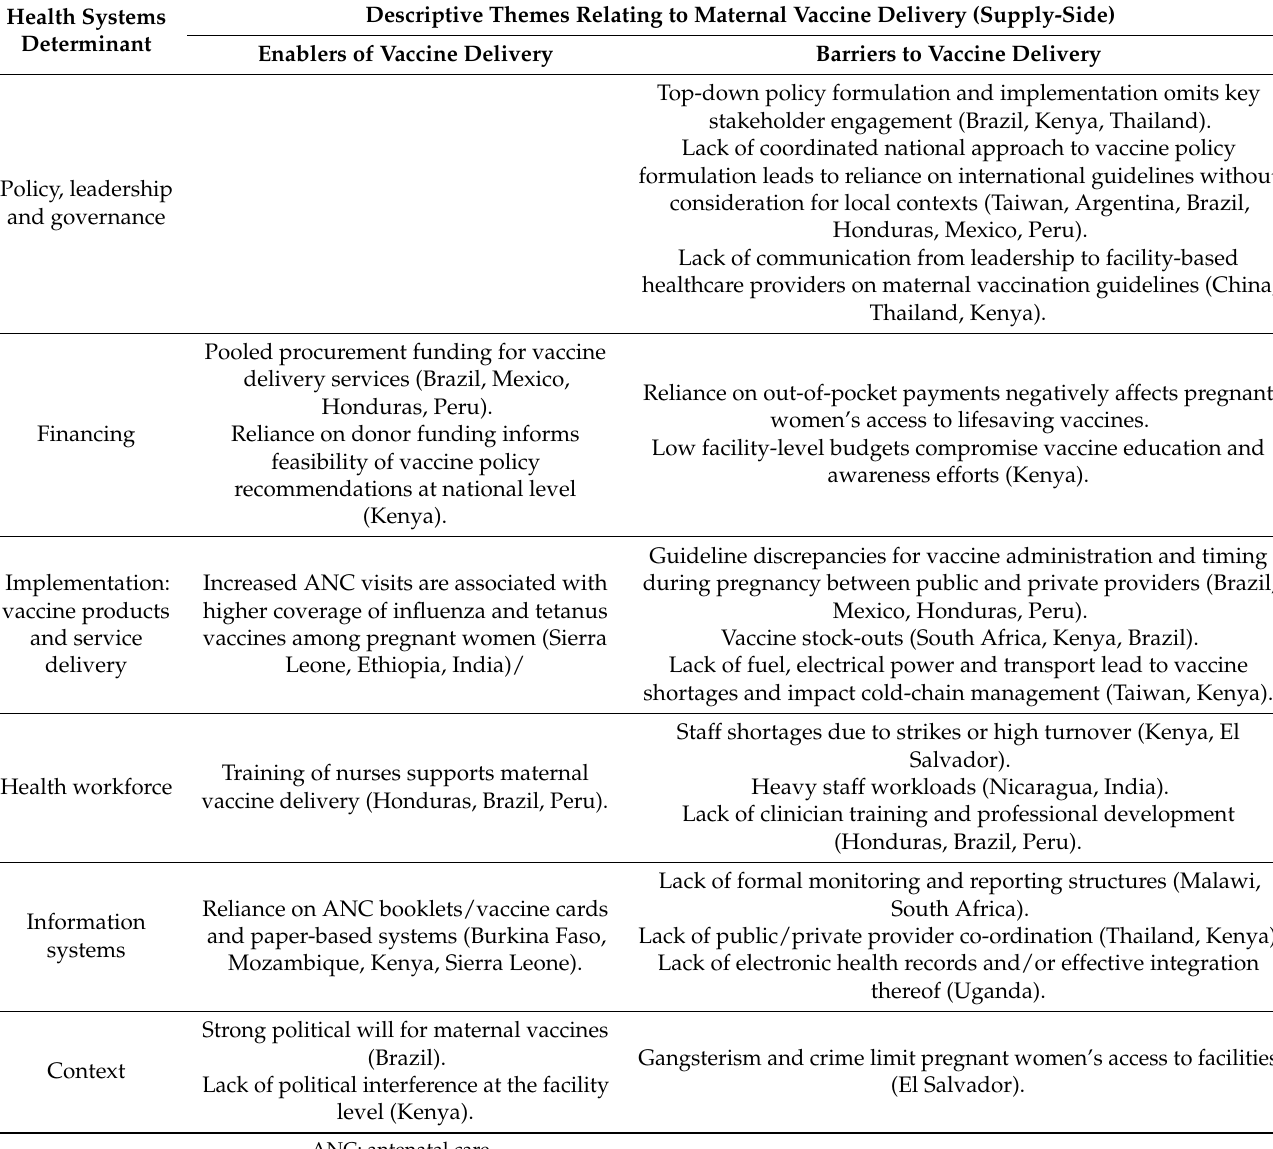
Table 2. Descriptive themes on health systems determinants of maternal vaccine delivery in